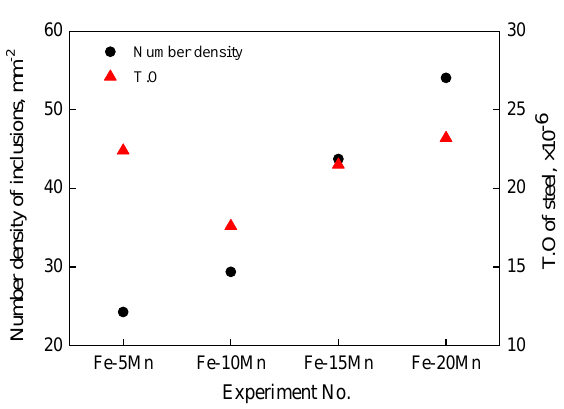
Figure 7. T.O content of steel and number density of inclusions.